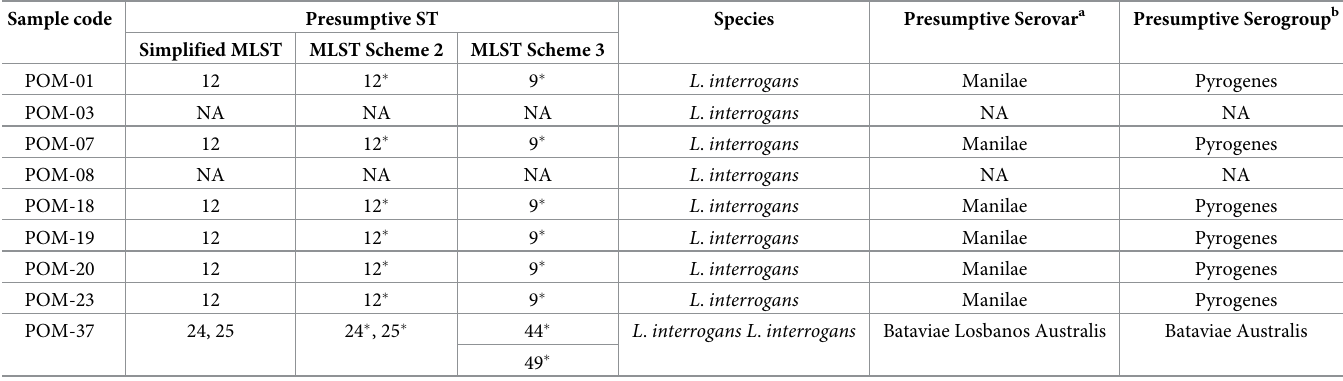
Table 4. Presumptive STs and serogroup of Leptospira in clinical samples based on simplified and published MLST schemes. Sample